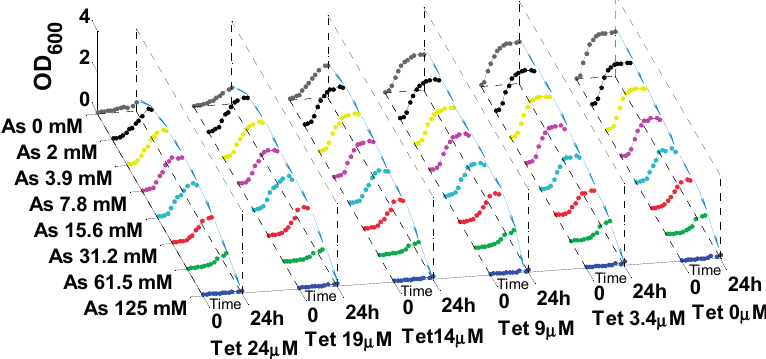
Figure 5. Growth curve of LSJC7 with tetracycline (Tet) and arsenate (As)